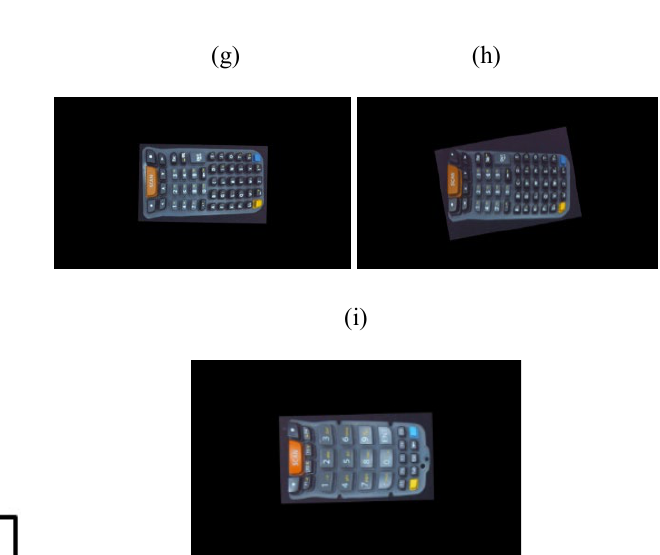
Figure 11. (a) Input image; (b) Resulting image after calibration; (c) Binary image & detecting the big blobs; (d)&(e)&(f) Resulting image after detecting type of keypads; (g)&(h)&(i) Resulting image after moving and rotating the keypads